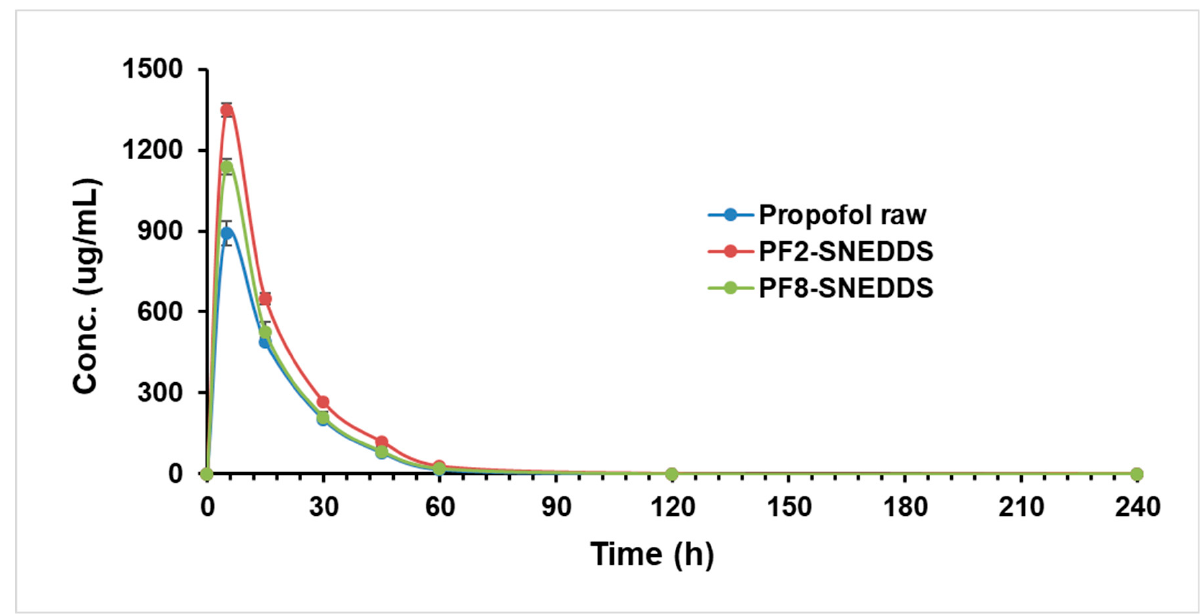
Figure 10. Plasma concentration–time profiles of propofol SNEDDS formulations PF2, PF8, and raw propofol (STD) after a single IV administration to rats at a dose equivalent to 10 mg/kg propofol (mean ± SEM, n = 6).